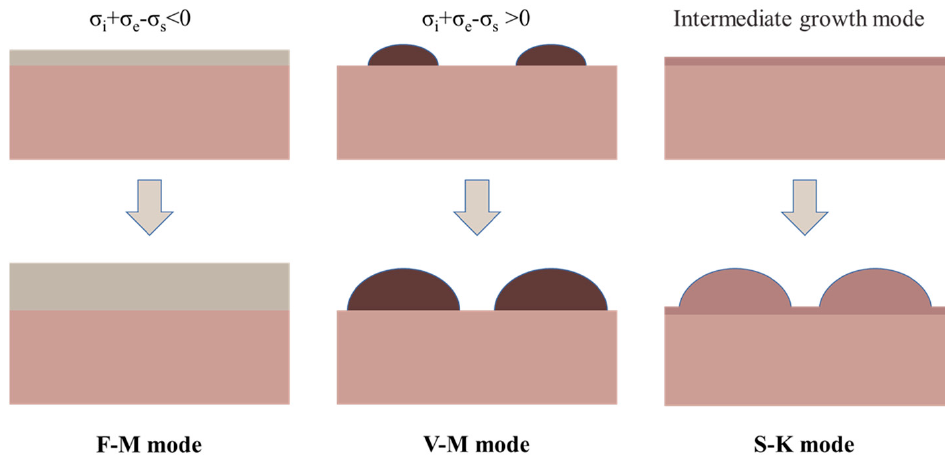
Figure 5. Schematic diagram of the three typical growth modes: F–M mode, V–M mode, and S–K mode.